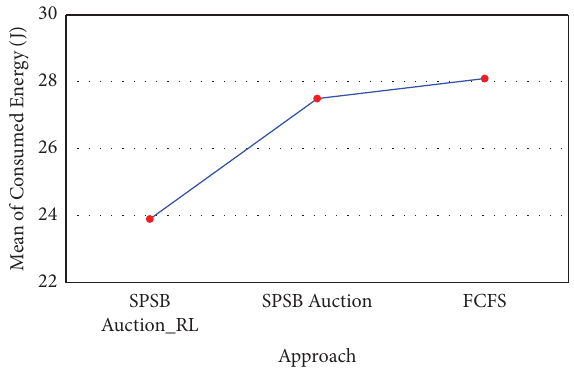
Figure 8: Te average energy consumption for diferent H : the selected ofoading approach has little impact 1 on the execution time.